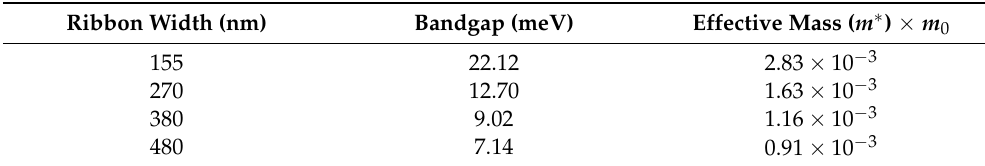
Table 1. Bandgap and charge carrier effective mass of GNRs considered in the present work. m 0 is the free-electron